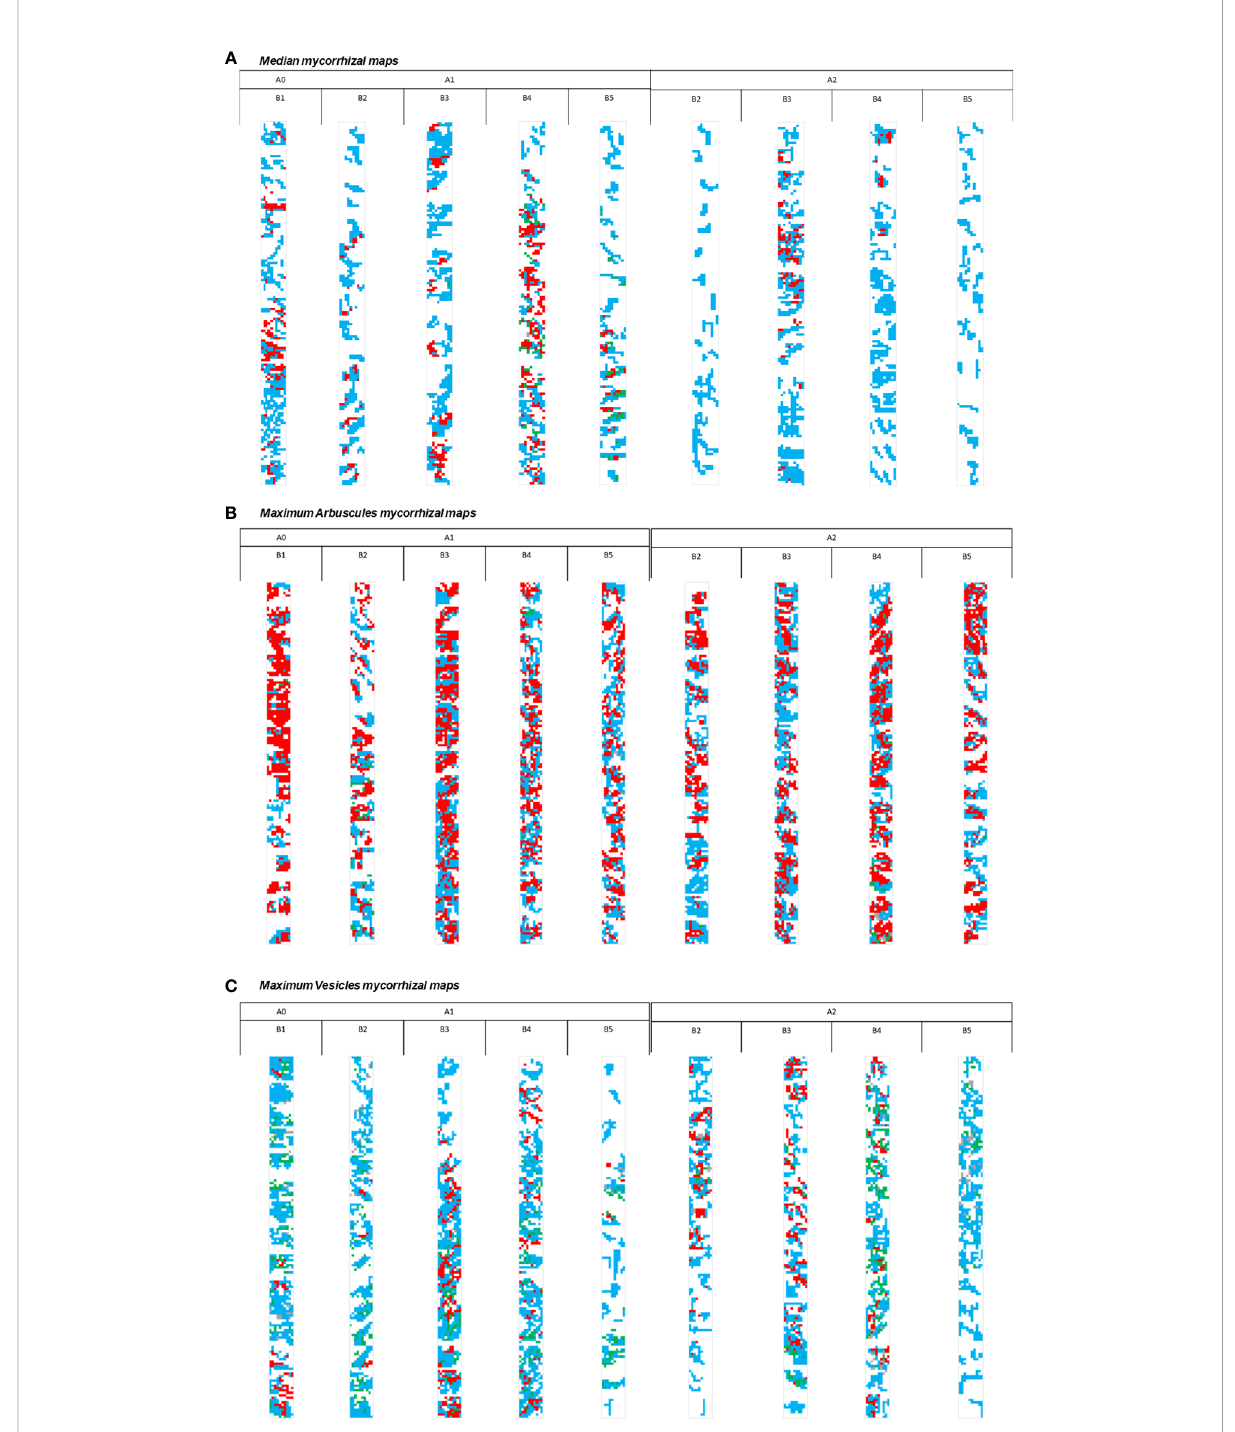
FIGURE 5 Mycorrhizal maps and colonization patterns shaped by the phenophase × treatment effect: (A) median colonization pattern, (B) maximum recorded arbuscules, and (C) maximum recorded vesicles. A0-B1, control variant (native mycorrhizal pro fi le) in phenophase 2 – 4 leaves; A1, untreated plants; A2, treated plants; B2, phenophase of 6 formed leaves; B3, phenophase of 8 – 10 formed leaves; B4, cob formation phenophase; B5, phenophase corresponding to physiological maturity. Color coding in mycorrhizal maps: hyphae (blue), arbuscules (red), vesicles (green), and spores